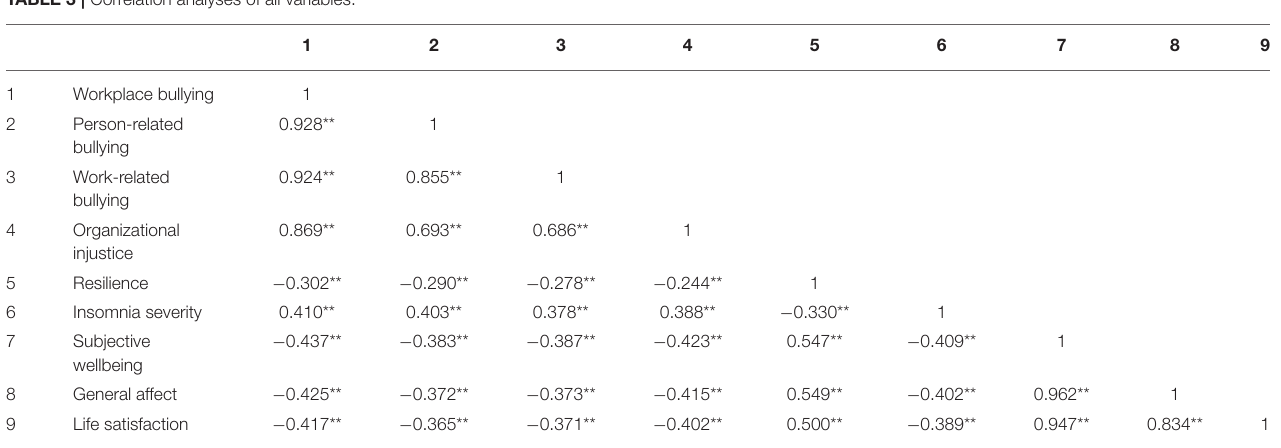
TABLE 3 | Correlation analyses of all